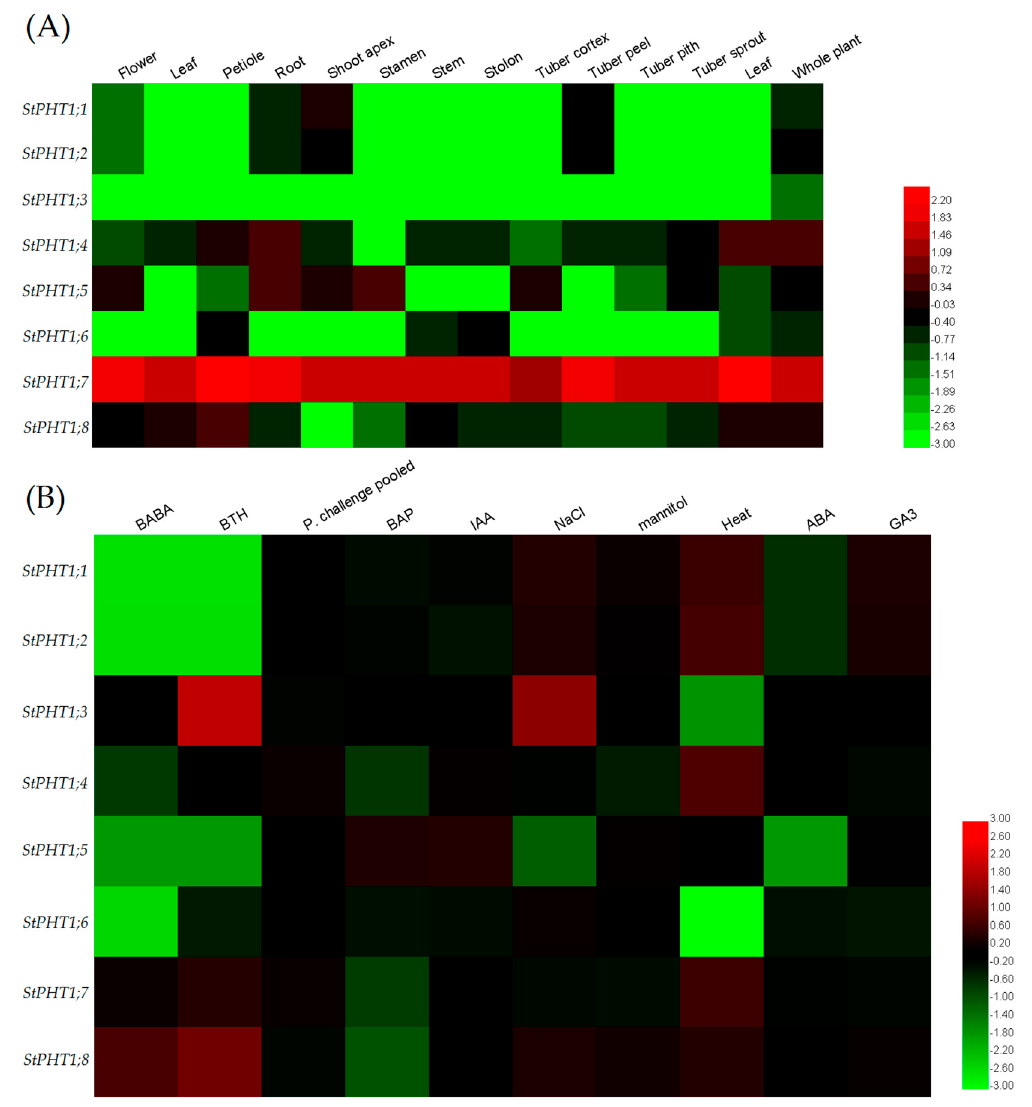
Figure 6. ( A ) Heat map of potato PHT1 genes tissue-specific expression. The data used in the figure was the base-10 logarithm of raw data from the PGSC database. Transcripts were detected using RNA-seq technology. Red indicates high relative gene expression, whereas green indicates low relative gene expression. ( B ) Heat map of the potato PHT1 genes under different stresses and phytohormone treatments. The data used in the figure = lg (experimental value/control value). The experimental value and control value were obtained from the PGSC database. Transcripts were detected using RNA-seq technology. Abiotic stresses included salt, mannitol, and heat; biotic stresses included DL-b-amino-n-butyric acid (BABA), stress-elicitors acibenzolar- S -methyl (BTH), and Phytophthora infestans ; and other stress responses were mainly induced by four plant hormones: 6-benzylaminopurine (BAP), indole-3-acetic acid (IAA), abscisic acid (ABA), and gibberellic acid (GA3). Red indicates gene up-regulation, while green indicates gene down-regulation.